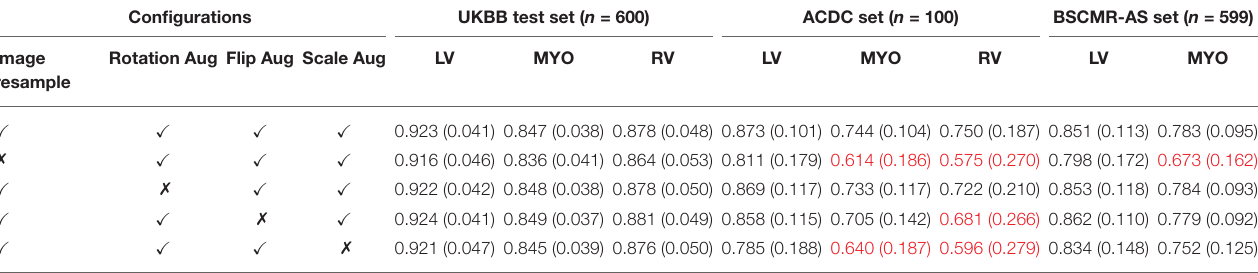
TABLE 5 | Cross-dataset segmentation performances of U-Nets with different training